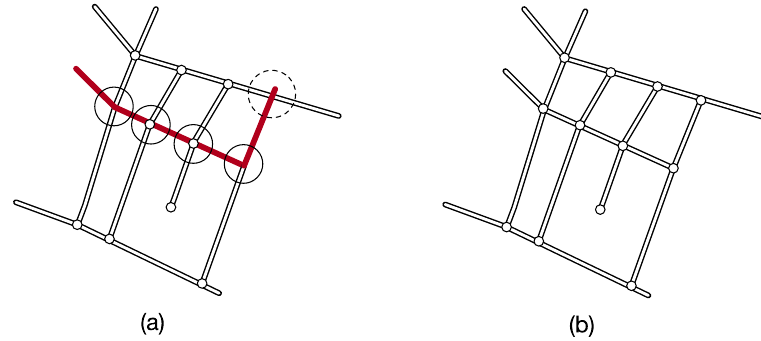
Figure 7. Updating a road network on the local scale: ( a ) generated road segments on the original road network; and ( b ) the updated road network.